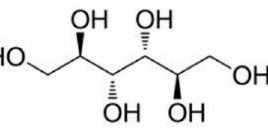
Figure 1. D -mannitol structural